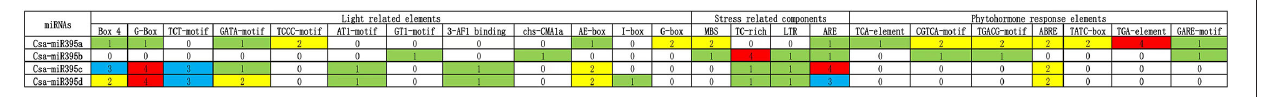
FIGURE 3 | Cis-acting elements in the promoter regions of Csa-MIR395s. These cis-acting elements were divided into three main categories; light-related elements, stress-related components, and phytohormone-response elements. The number of these cis-acting elements was represented by different colors.